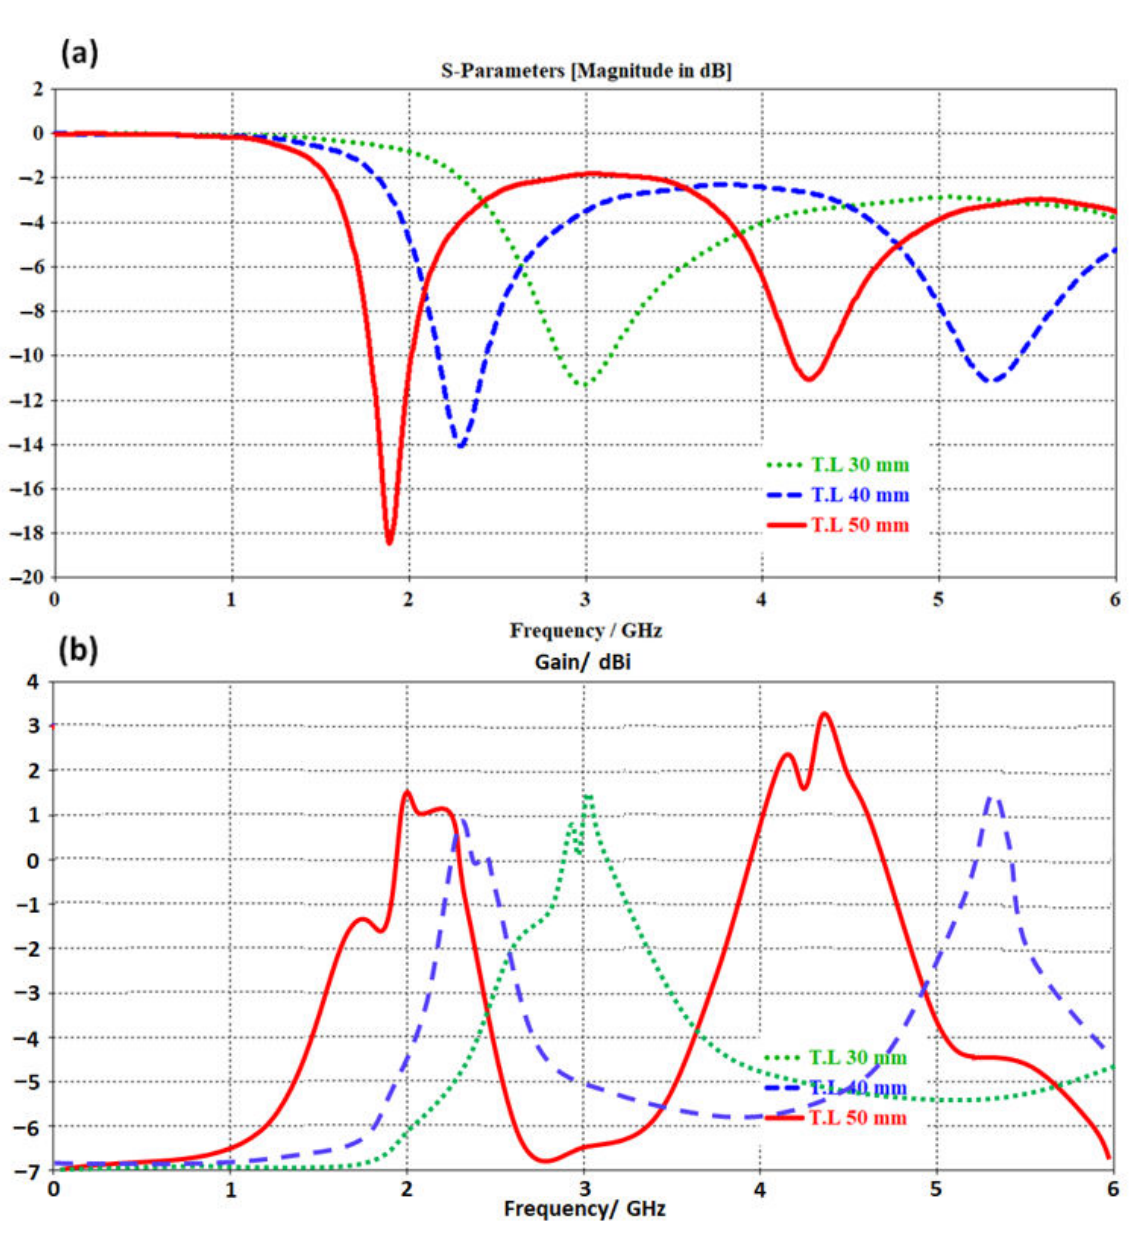
Figure 2. Antenna performance with changing L value: ( a ) S 11 and ( b ) gain